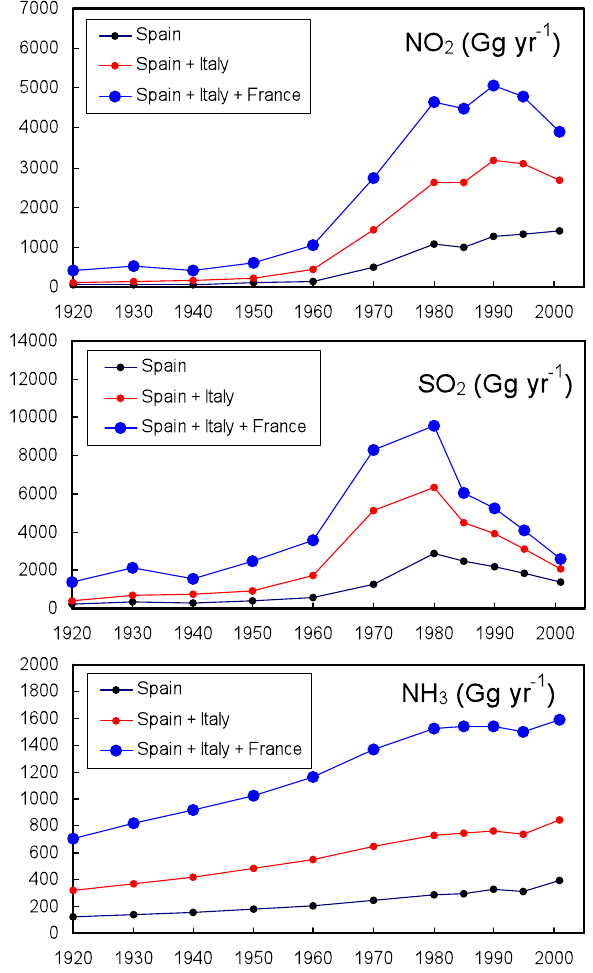
Fig. 10. Emissions of NO 2 , SO 2 , and NH 3 from Spain, Italy, and France from 1920 to 2001. Adapted from Fagerli et al.